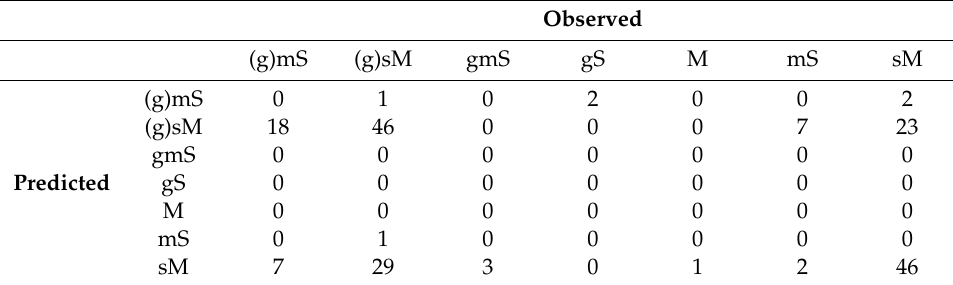
Table A2. Categorical Folk S-LOO CV error matrix.